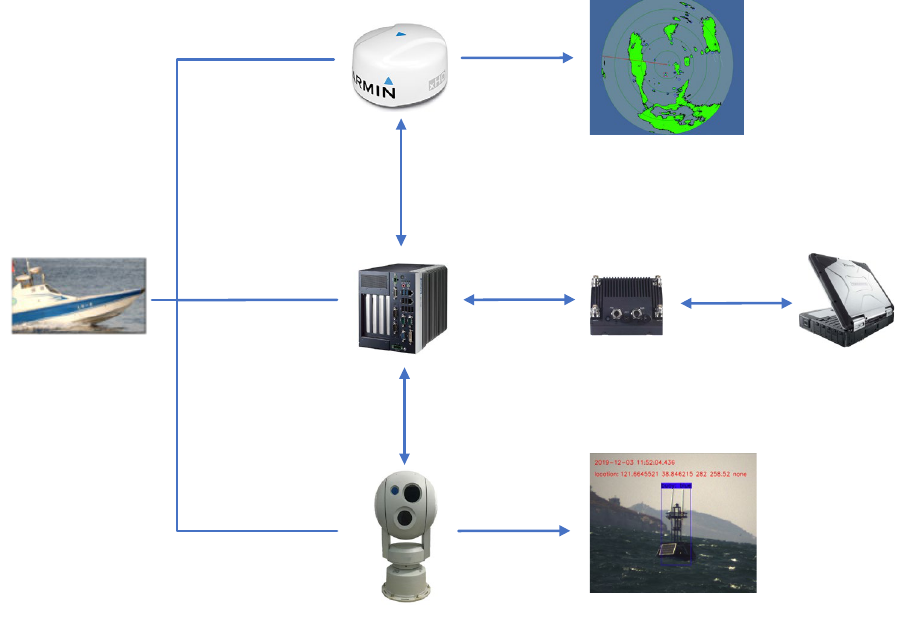
Figure 2. USV Perception system.